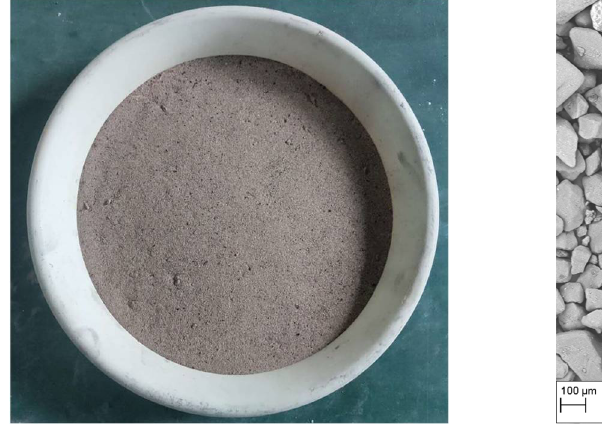
Figure 2. A photo of the aeolian sand ( a ) and microscopic structure of aeolian sand 50× ( b ).